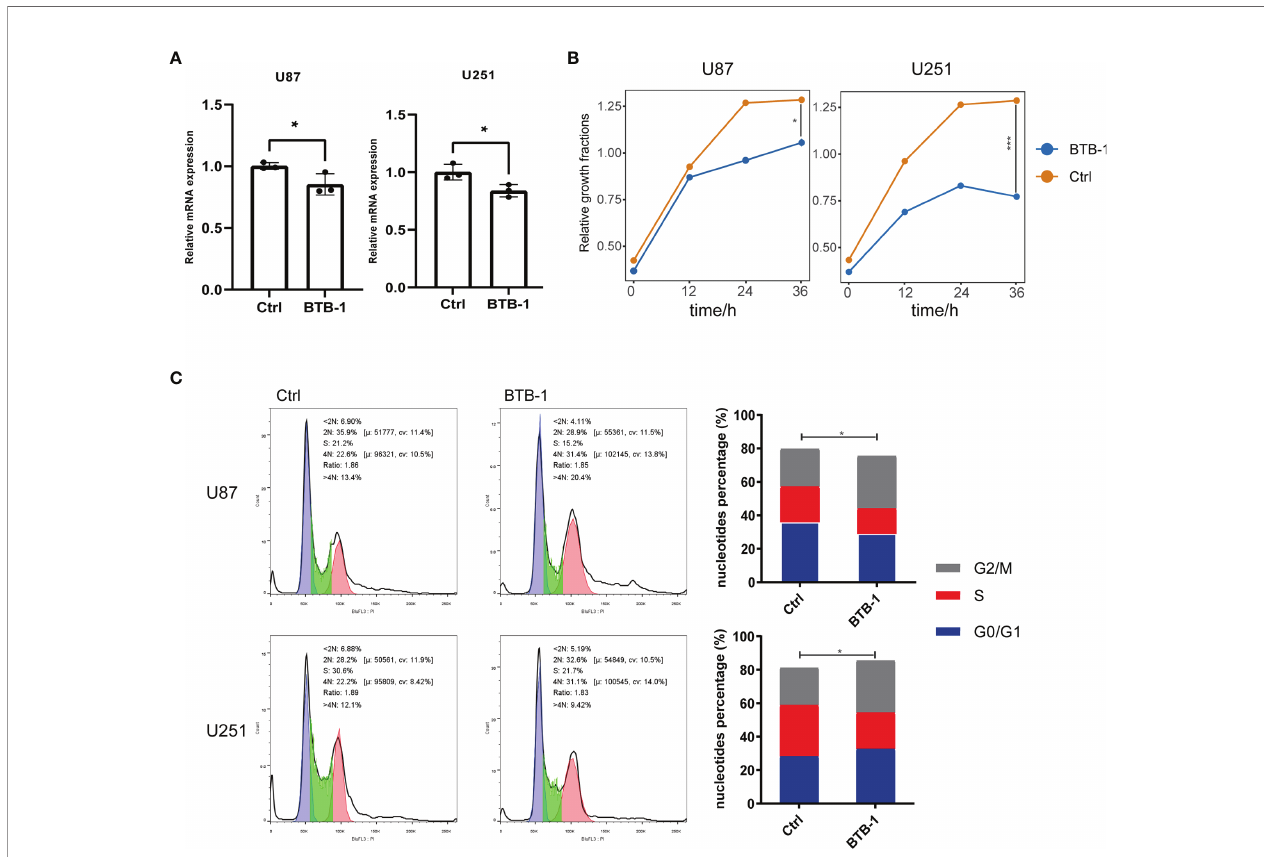
FIGURE 9 | Evaluation of the effect of KIF18A inhibitor BTB-1 on the function of glioma cell lines. (A) Evaluation of the effect of BTB-1 on the transcription level of KIF18A in glioma cells. (B) Evaluation of the effect of BTB-1 on glioma cell proliferation. (C) Evaluation of the effect of BTB-1 on glioma cell cycle. "*" means 0.01<p<0.05, "***"means